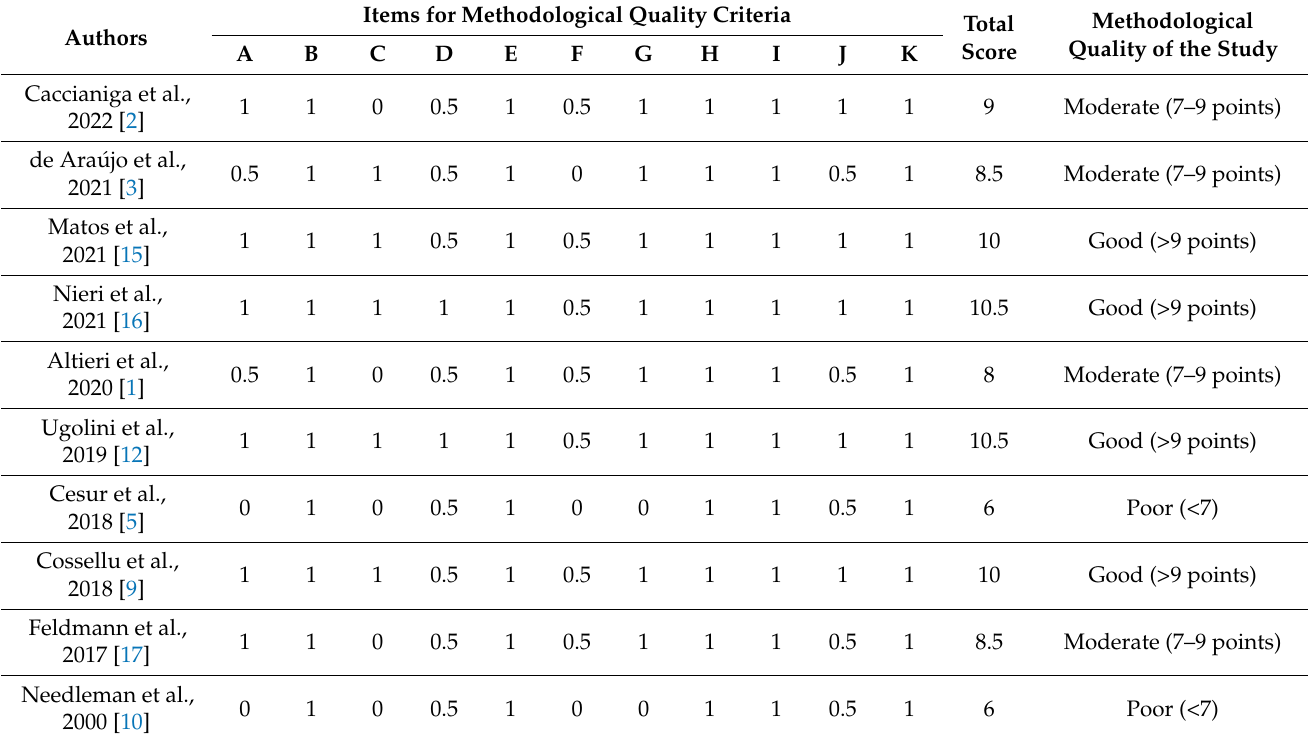
Table 4. Methodological Quality of included